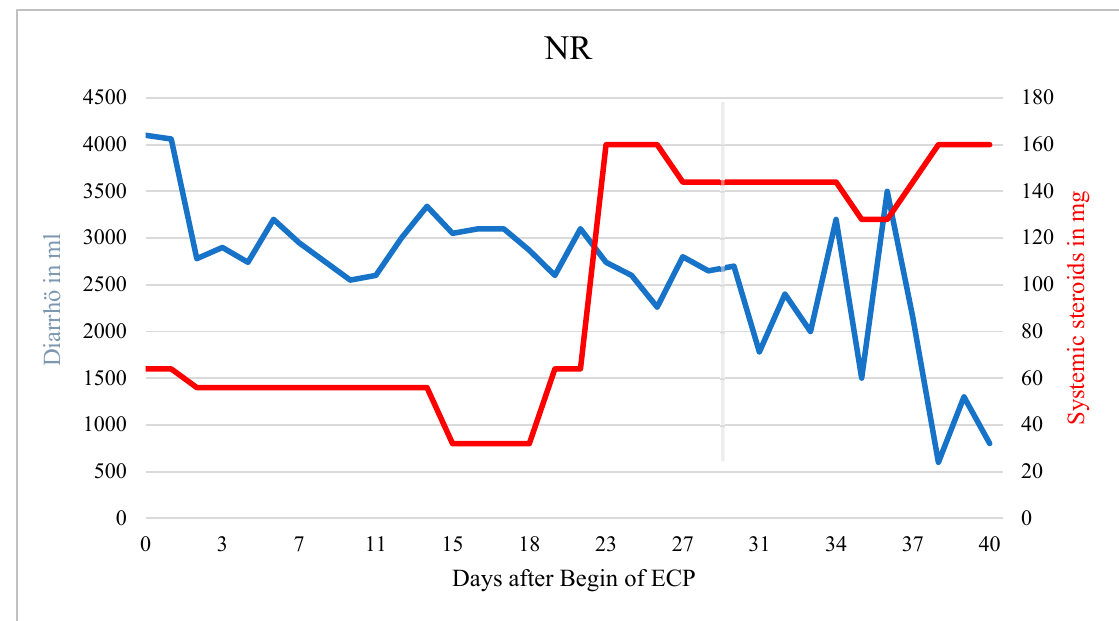
Figure 2. Patient with partial response. Significant reduction of diarrhea and steroid usage during ECP treatment. End of ECP marked with a vertical gray line.